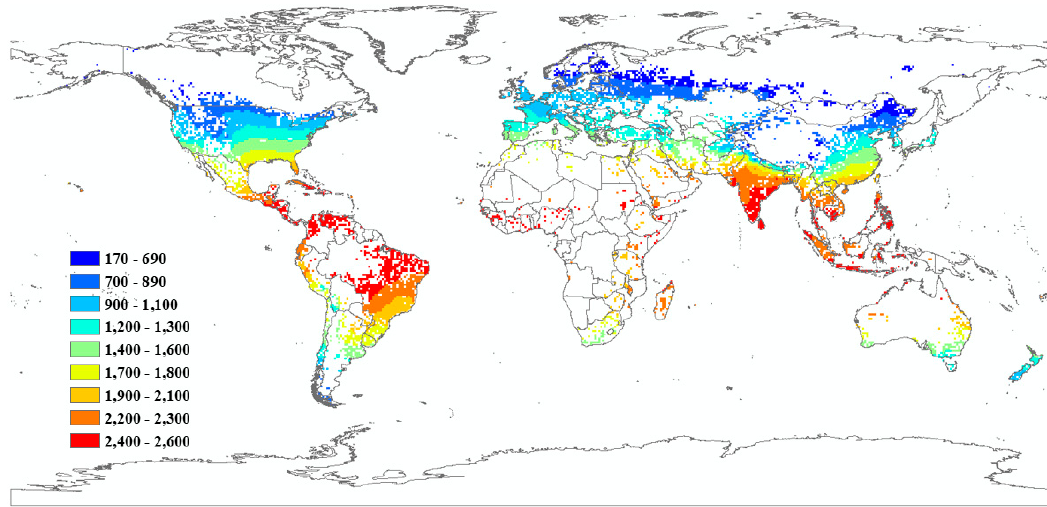
Figure 2. Historical net irrigation water requirement in 1999. The same irrigated area than in 1960 is used the same in figure 1.